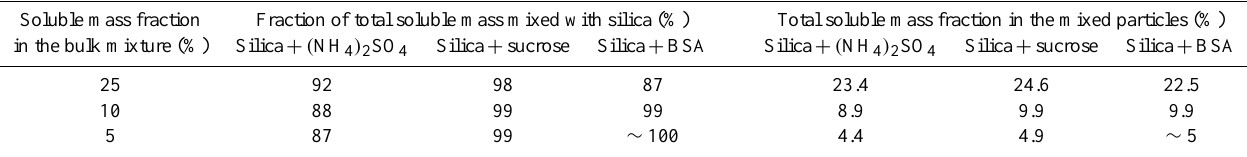
Table 2. The total soluble fraction of the solute masses in the bulk mixtures, the fraction of total soluble mass mixed with silica, the average soluble mass fraction of the mixed particles (calculated from particle size distributions, see text for details). Soluble mass fraction Fraction of total soluble mass mixed with silica (%) Total soluble mass fraction in the mixed particles (%) in the bulk mixture (%) Silica + ( NH 4 ) 2 SO 4 Silica + sucrose Silica +